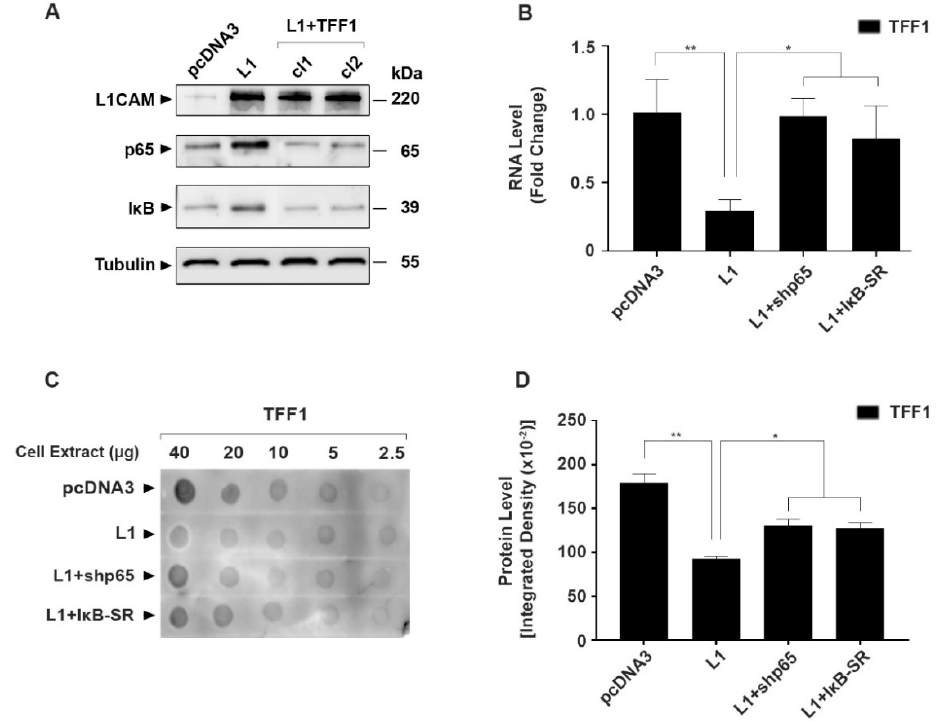
Figure 4. The inverse relationship between the expression of TFF1 and NF- κ B signaling components in L1-expressing CRC cells. ( A ) The levels of p65 and I κ B protein were determined in the CRC cell clones described in Figure 3; ( B ) the level of TFF1 RNA was determined in L1-expressing CRC cell clones in which NF- κ B signaling was blocked by either an shRNA to p65 (L1 + shp65) or by the expression of the I κ B super-repressor (L1 + I κ B-SR); ( C , D ) quantitative immuno-dot-blot analysis of TFF1 protein levels in the CRC cell clones described in ( B ). * p < 0.05, ** p < 0.01. The uncropped blots are shown in Supplementary File S1.